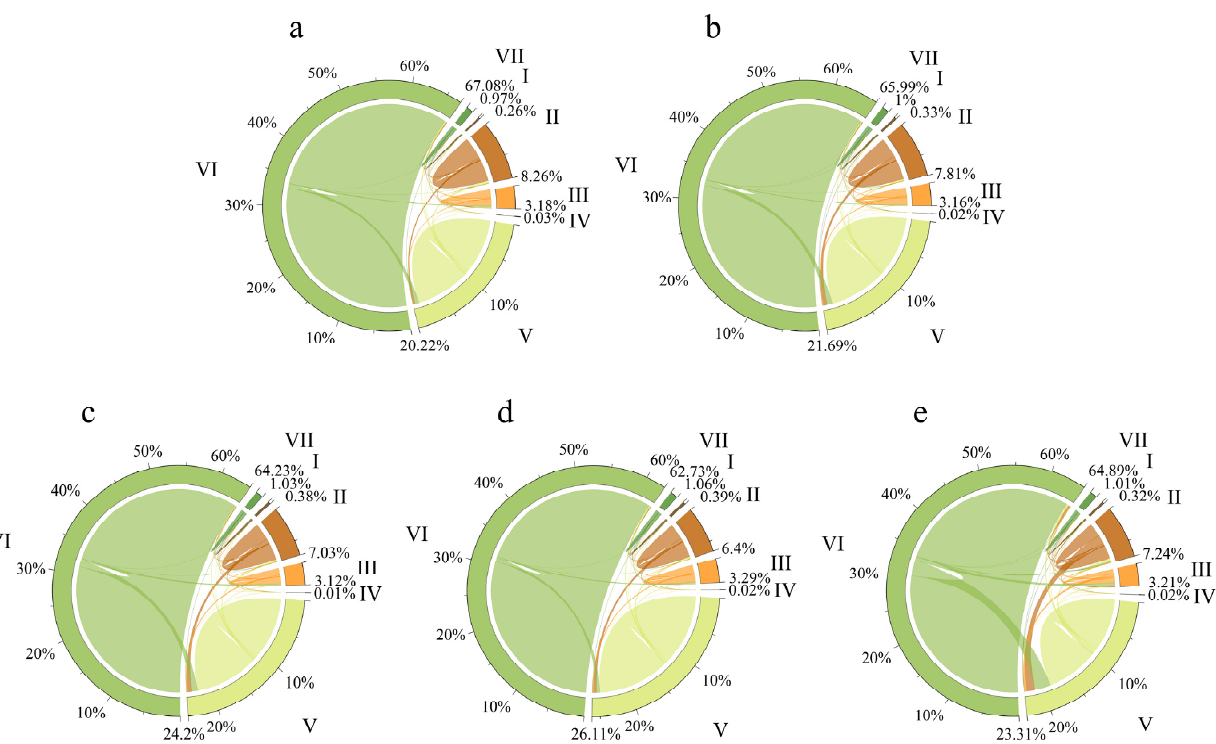
Figure 3. Land use change chord diagram in 2002–2018: (I) Impervious, (II) Grassland, (III) Shrub, (IV) Barren, (V) Cropland, (VI) Forest, (VII) Water. Note: ( a ): 2002–2006; ( b ): 2006–2010; ( c ): 2010–2014; ( d ): 2014–2018; ( e ): 2002–2018.